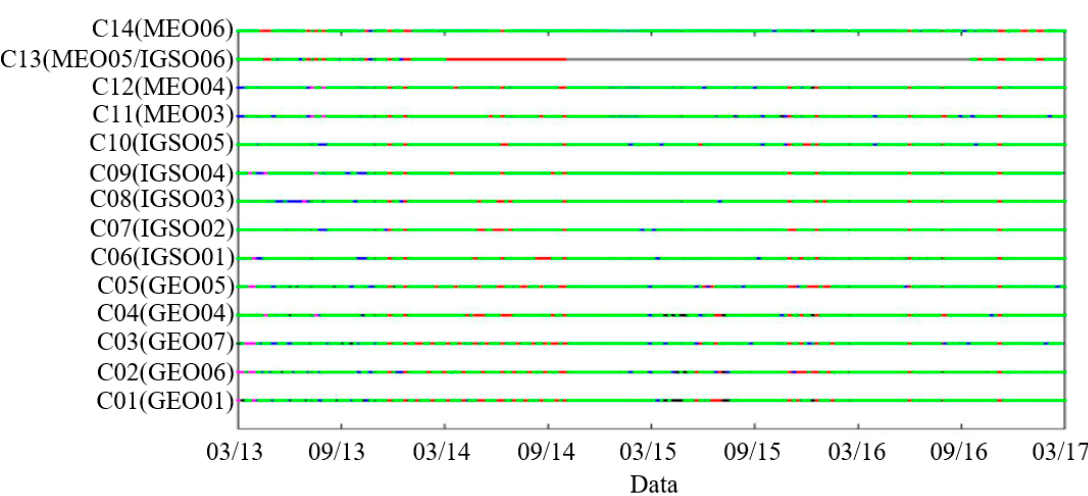
Figure 1. The history of the BDS constellation healthy operational status and abnormal operational status (The green dots represent a healthy operational status, and the other dots represent an abnormal operational status).